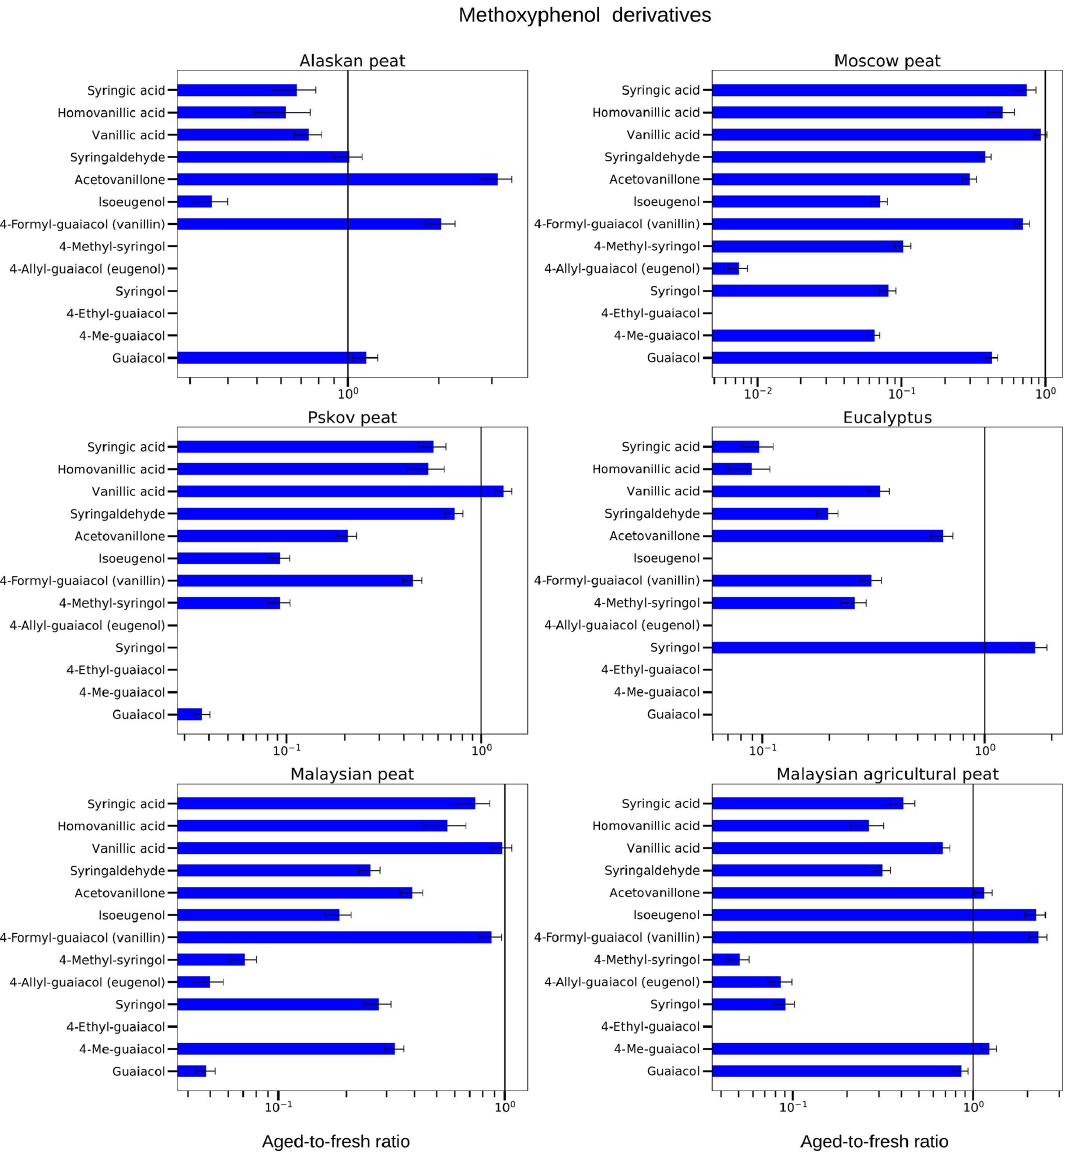
Figure 8. Aged-to-fresh ratios of total (gas + particle) EFs for methoxyphenols from biomass-burning emissions for six different biomass types presented in log scale. We did not burn fuels in replicates, and the standard-deviation (SD) values were calculated based on the replicate analysis of similar fuels (with the same experimental conditions) from our previous campaigns. SD values derived from EFs were scaled to